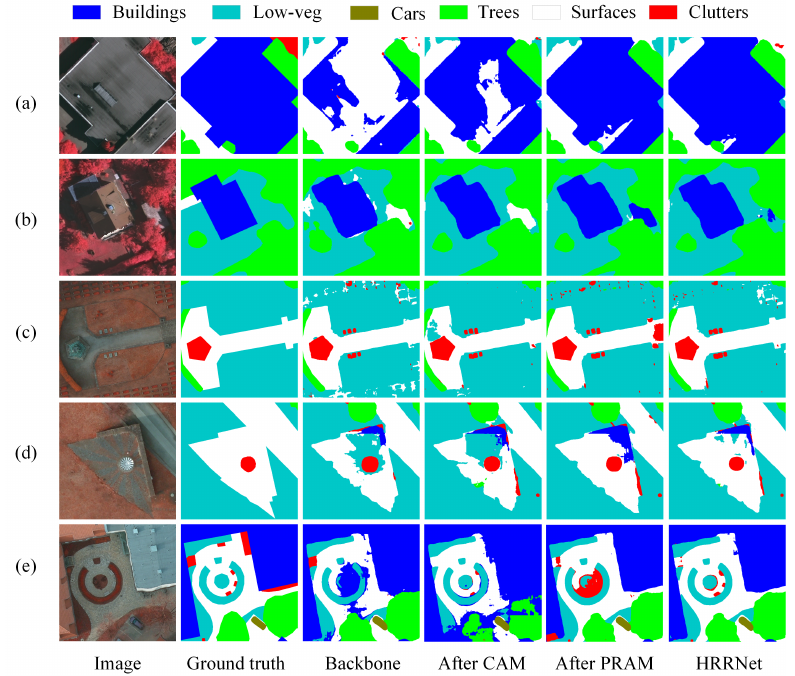
Figure 5. On the basis of backbone, the segmentation result map after adding the CAM and PRAM in sequence. Rows ( a , b ) are the selected results on the Vaihingen dataset. Rows ( c – e ) are the selected results on the Potsdam